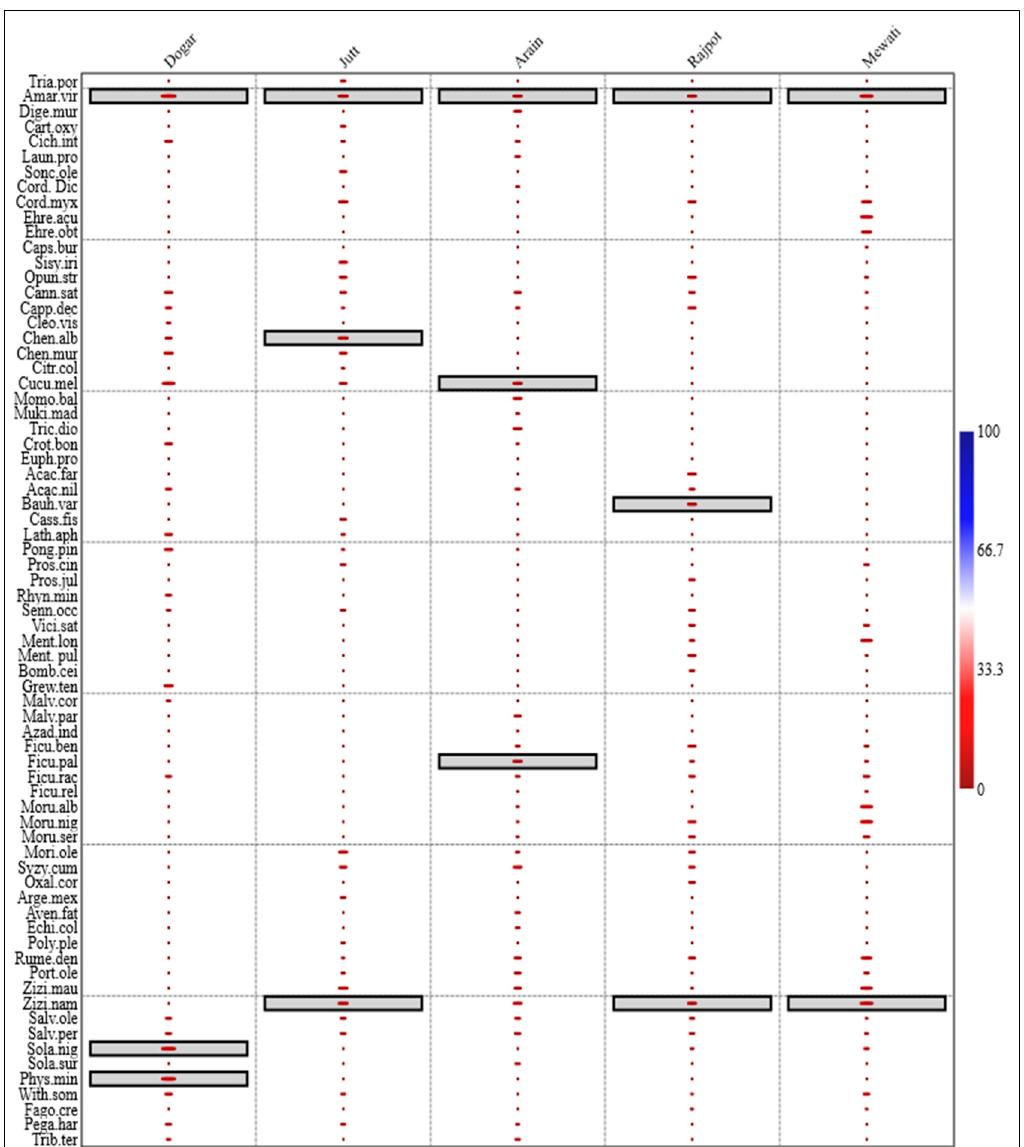
Figure 7. Indicator food species in different ethnic groups in the semi-arid region of Punjab Pakistan. Indicator food plants are highlighted in boxes in different groups. Amaranthus viridus was a common indicator species for all ethnic groups, while Ziziphus nummularia was a common indicator species for three ethnic groups (Jutt, Rajput, and Mewati). The Y-axis represents the species code (for full species name see Table 2) and the colors represent the indicator value of species in different ethnic groups.